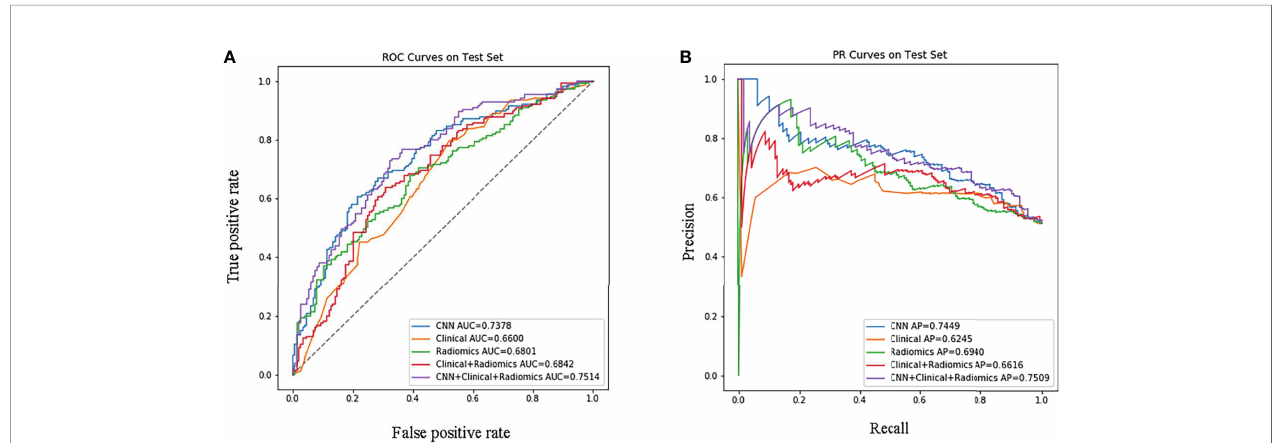
FIGURE 2 | Performance evaluation of the models in the test set. (A) Receiver Operating Characteristic curve; (B) Precision-Recall curve. ‘ CNN+Clinical+Radiomic ’ refers to ModelCNN+radiomic+clinical, ‘ Clinical+Radiomic ’ refers to Modelradiomic+clinical, ‘ Radiomic ’ refers to Modelradiomic, ‘ Clinical ’ refers to Modelclinical, and ‘ CNN ’ refers to ModelCNN.